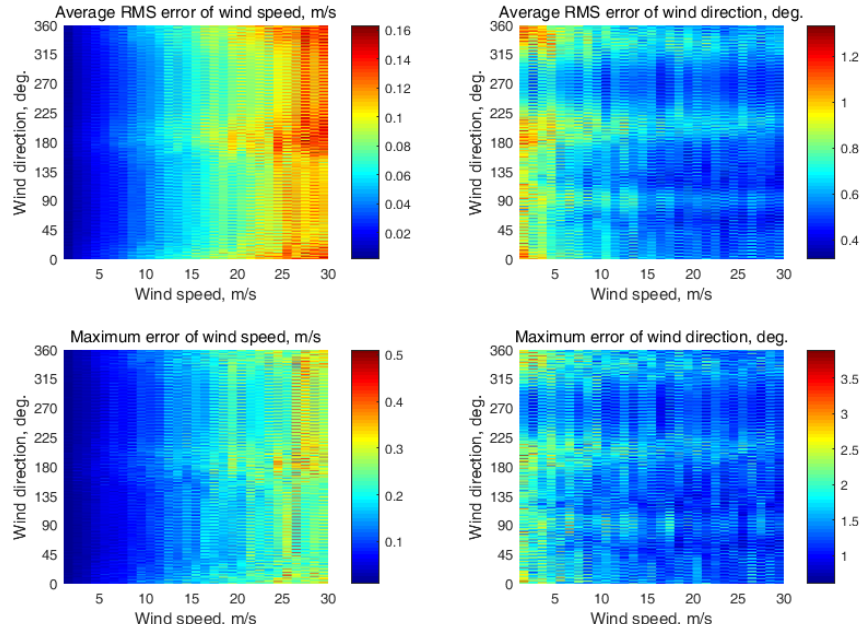
Figure A12. Semicircular wind retrieval results at the (45°, 50°) incidence angle combination.